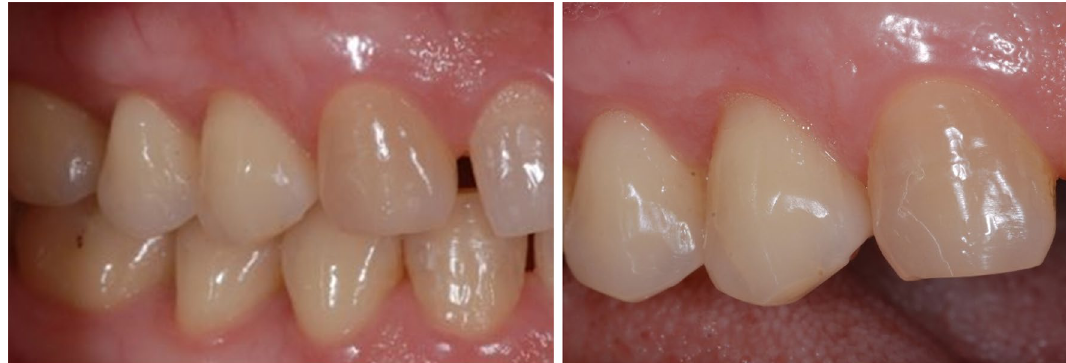
Figure 2. Class V restoration on upper first premolar at baseline (left) and 1-year recall (right) without any visible change.